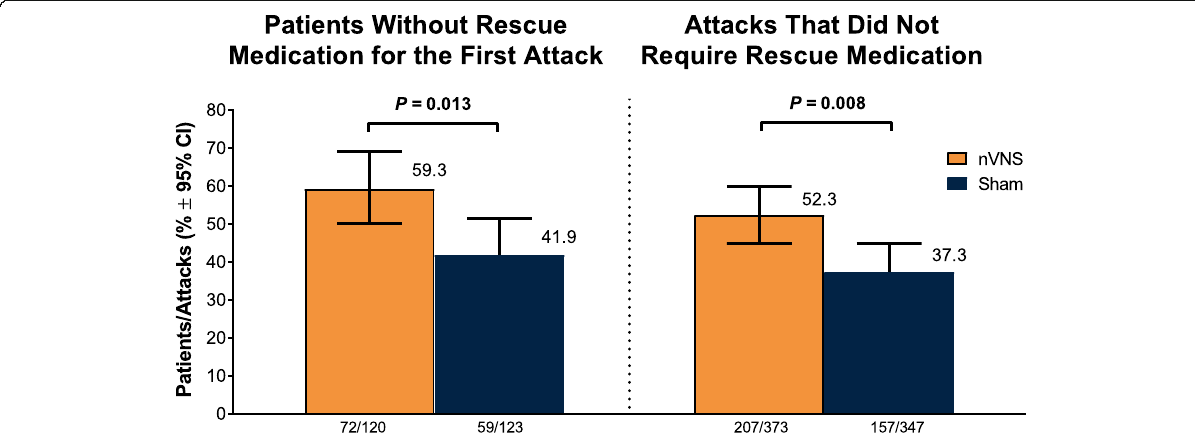
Fig. 4 Rescue Medication Use. Models are adjusted for the patients ’ baseline pain score, use of preventive therapies, and presence of aura; data for number of patients are unadjusted numbers. Abbreviation: nVNS, non-invasive vagus nerve